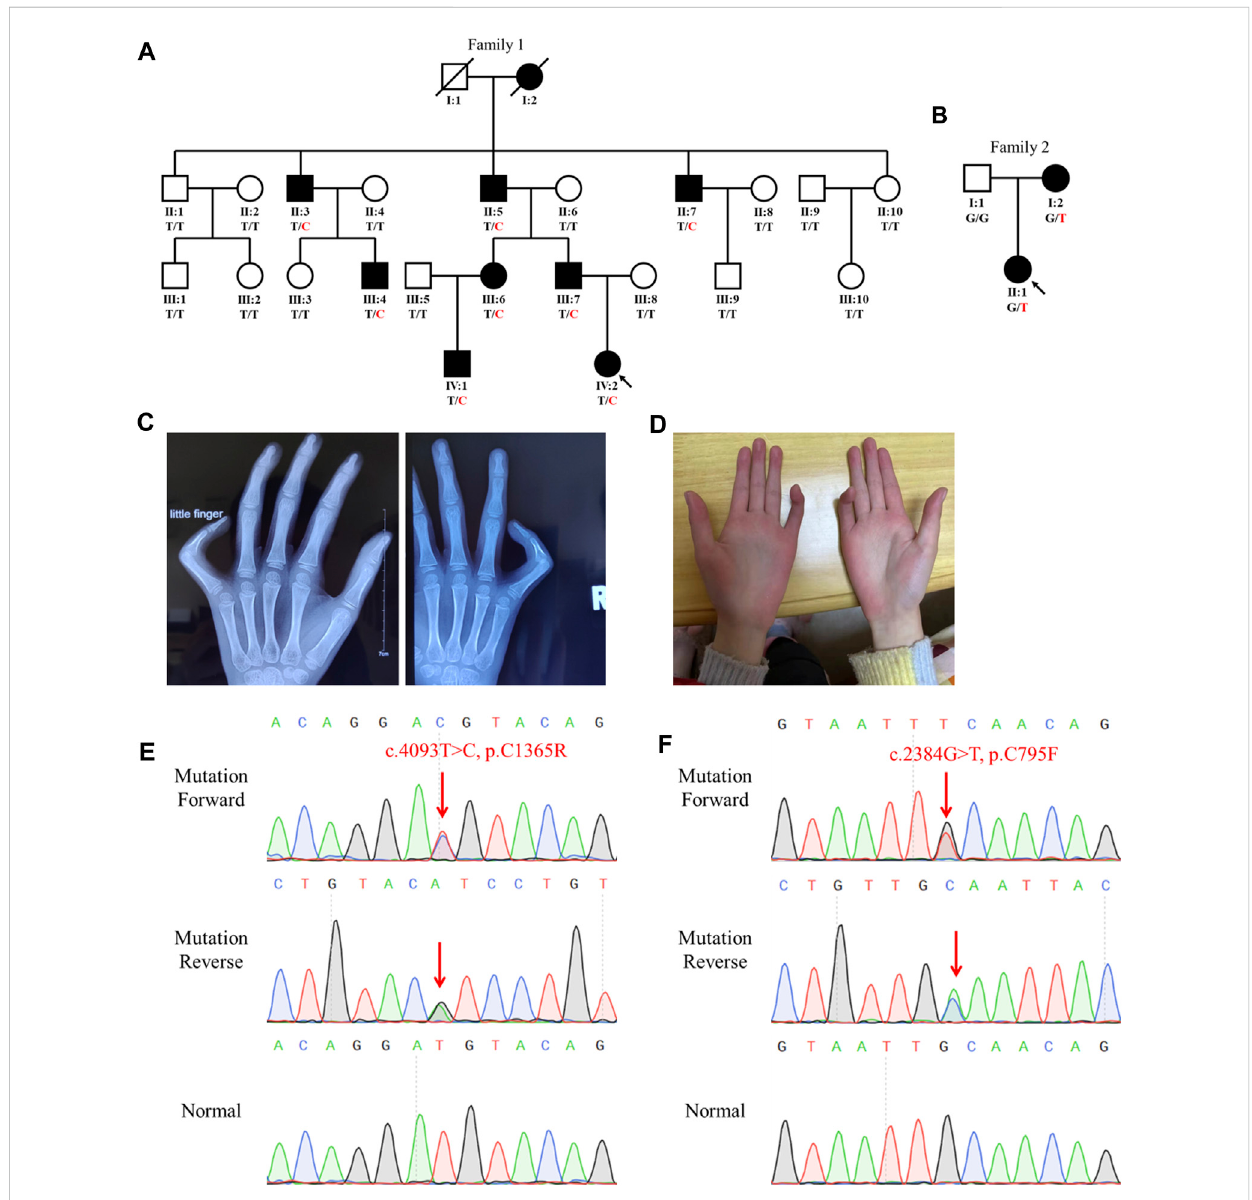
FIGURE 1 Family genogram, symptoms, and Sanger sequencing of the probands. (A,B) Genogram of the F1 family and F2 family. Black symbols represent the affected members, slashes indicate those who died, and the arrow indicates the proband. All recruited subjects underwent genetic testing, and their genotypes are identi fi ed by letters and a slash, with red representing variants. Question marks represent unknown data or symptoms. (C,D) F1 family probandhadarachnodactylyandbilateralcontractureofthe fi fth fi ngers. (E,F) Sequencingresultsof FBN2 variantsusingSangersequencing.Thered arrow points to the variant